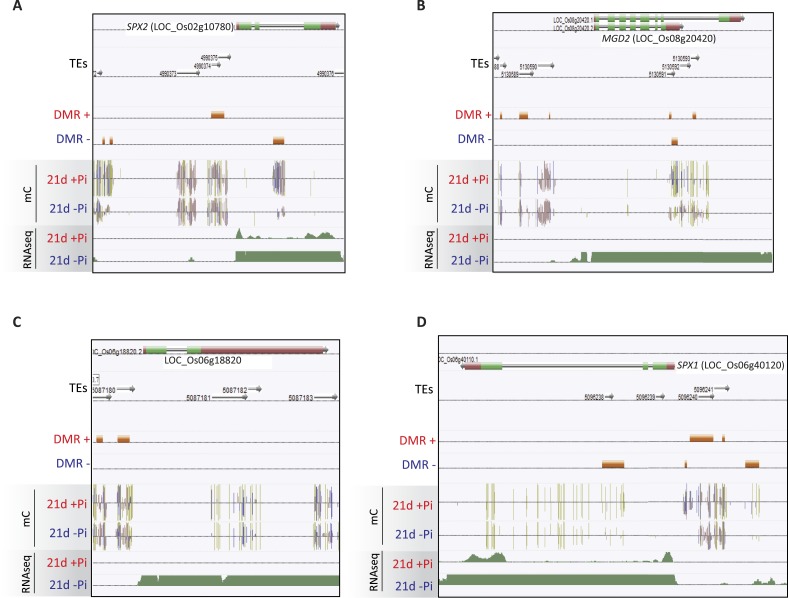
Examples of PSI DMRs.